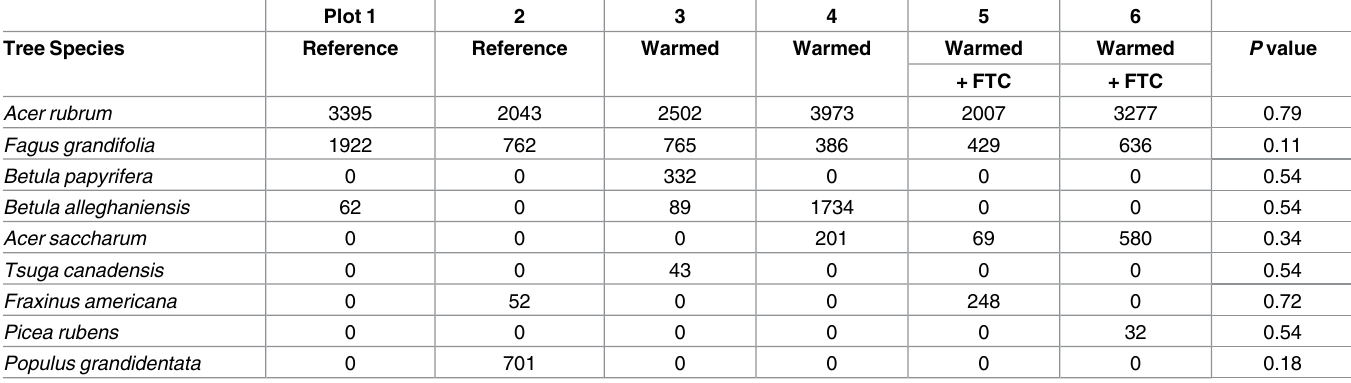
Table 1. Total basal area of trees in each of the six CCASE plots. Values are totals per tree species within each plot measuredin June 2012. Units are cm 2 . There were no statisticallysignificantdifferencesin total basal area of individual tree species comparing reference (plots 1 and 2) to treatment (plots 3–6) plots ( P > 0.05 for all tree species; see below) or for total basal area across all tree species comparing reference to treatment plots ( P =